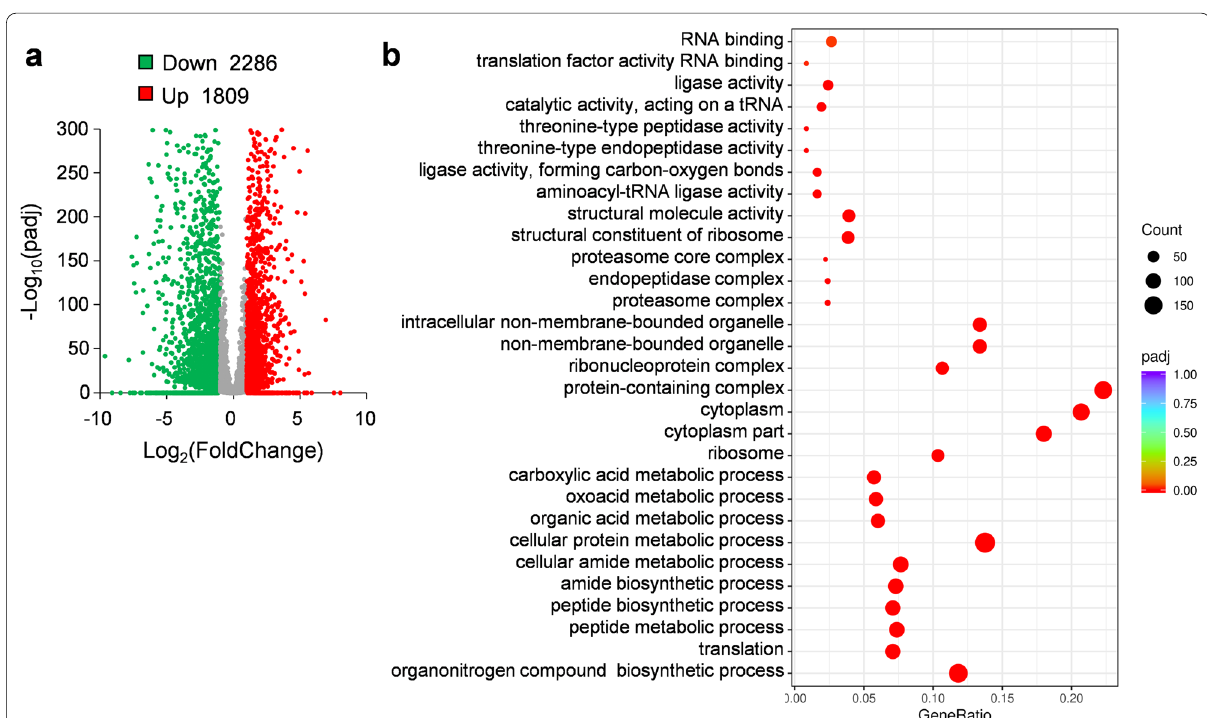
Fig. 7 Transcriptome analysis of differentially expressed genes in ∆ CgHOS2 and the WT. a Scatter plots showing the genes that are differentially expressed in ∆ CgHOS2 and the WT